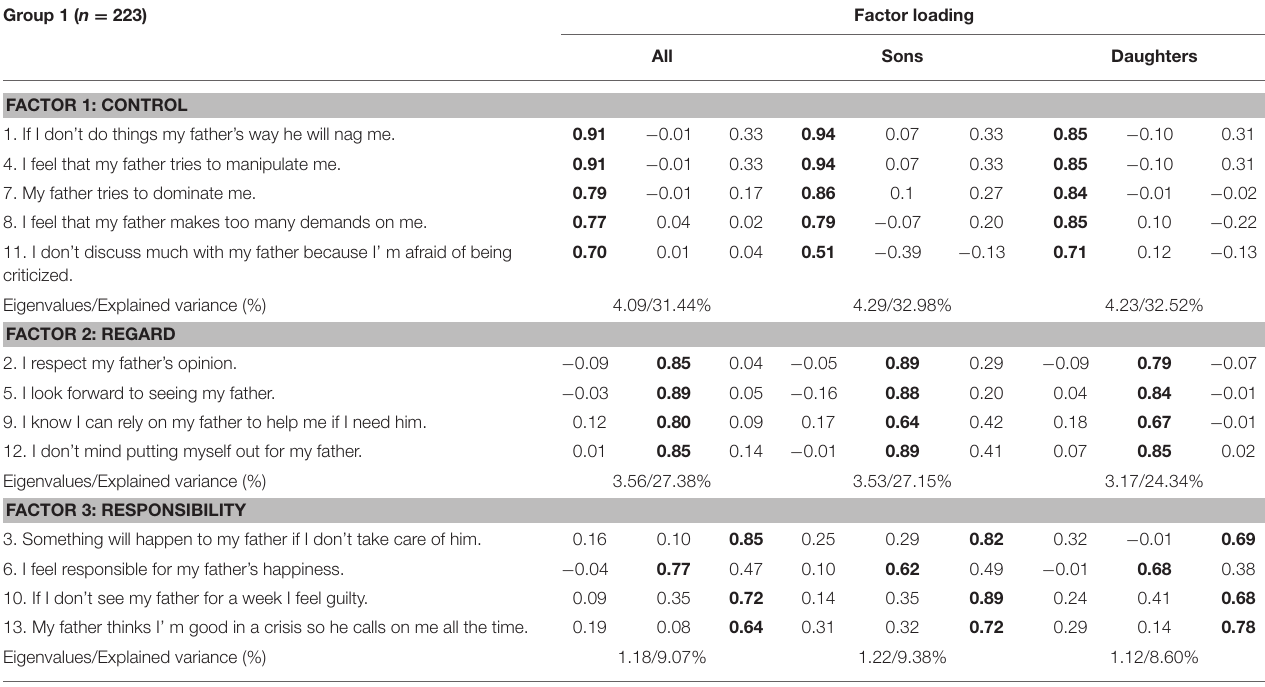
TABLE 3 | Principal Factor analysis of the PACQ for father.